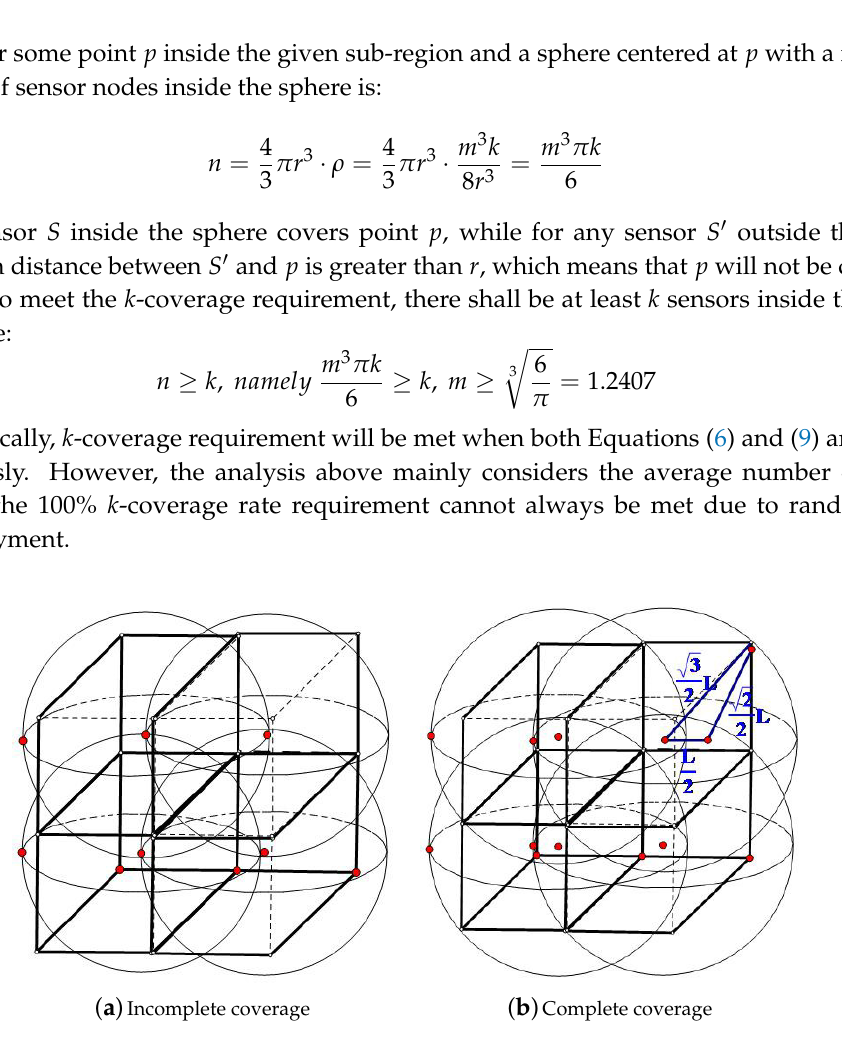
Figure 1. Coverage of a cubic grid. ( a ) Incomplete coverage; ( b ) Complete